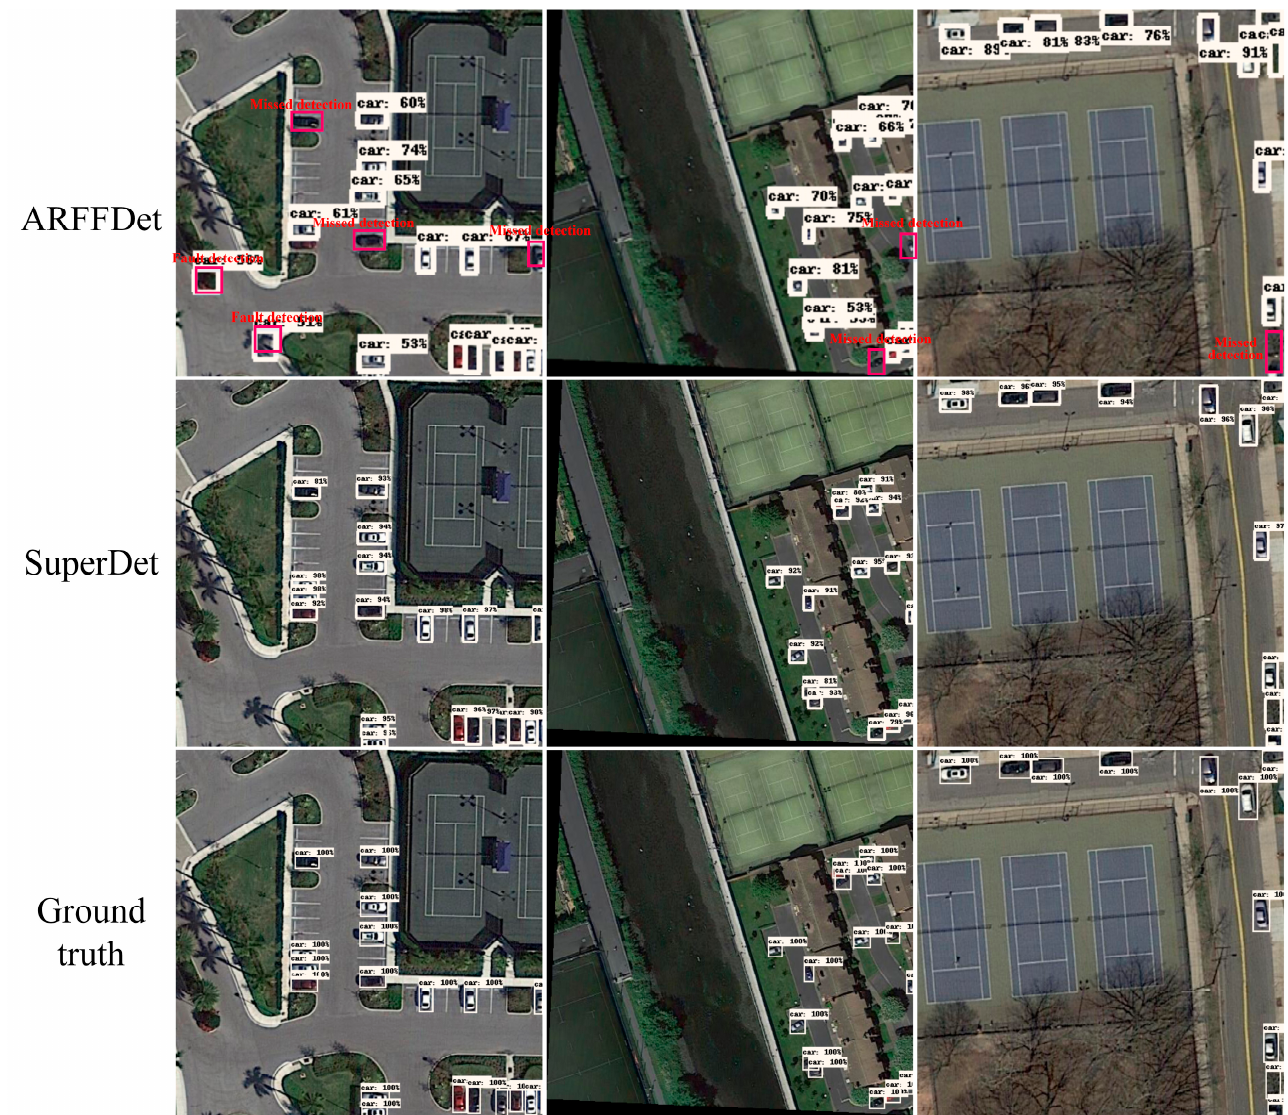
Figure 7. Visual comparative results of SuperDet on DOTA dataset. First row: detection results of ARFFDet. Second row: detection results of SuperDet. Third row: Ground truth.